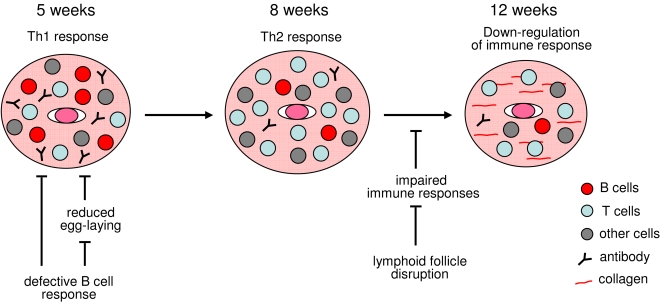
A working model for the function of B cells in granuloma pathology and the effect of lymphoid follicle disruption on down-regulation of the immune response and granulomas.At early stages of Schistosoma infection (5 weeks), B cell function is required for granuloma formation. Mice with B cell deficiencies fail to mount an effective inflammatory reaction. Meanwhile, deficient B cell function also affects liver egg burden and produces impaired granuloma pathology. At later stages (7–8 weeks), the Th2 response exerts a dominate effect on granuloma pathology (ref. 2) and is accompanied by both an accumulation of CD4+ cells and a reduction of B220+ cells and antibody in granulomas. Infection by Schistosoma destroys the lymphoid follicles at 8 weeks and degrades immune responses, such as the T helper cell-dependent B cell response to OVA. Finally, granuloma pathology diminishes after 12 weeks of infection.